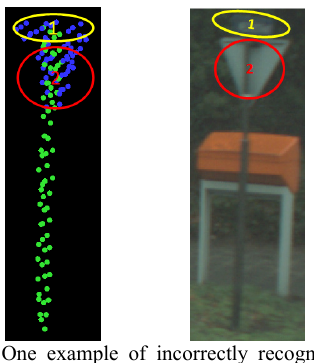
Figure 8. One example of incorrectly recognized road